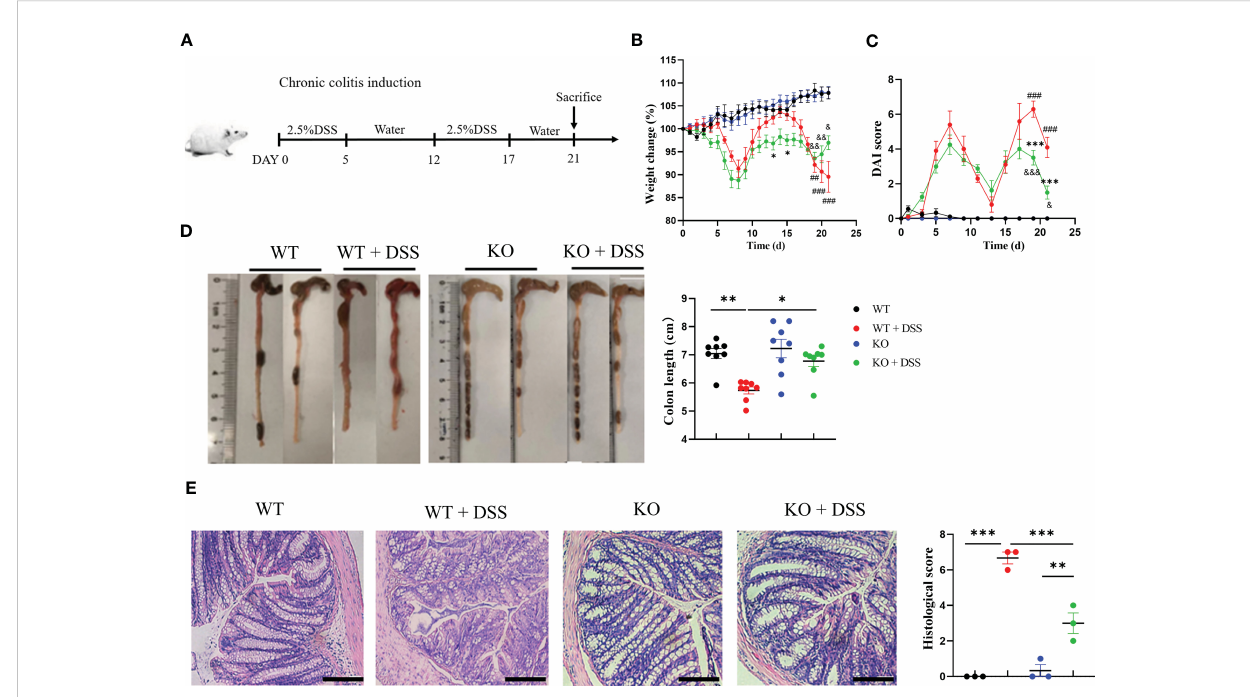
FIGURE 5 PAD4 de fi ciency also improved disease indexes in chronic DSS-induced colitis. (A) Two cycles administration of DSS induced chronic colitis. (B) Weight change. (C) DAI score, ( ### P<0.001 , ## P<0.001 compared with WT group; * P<0.05 , *** P<0.001 compared with WT+DSS group; & P<0.05 , && P<0.01 , &&& P<0.001 compared with KO group). (D) Colon length (n=6-8). (E) Microscopic total damage scores and representative H&E- stained colon sections of mice (n=3). Bars represent 50 m m. * P<0.05 , ** P<0.01 , *** P<0.001